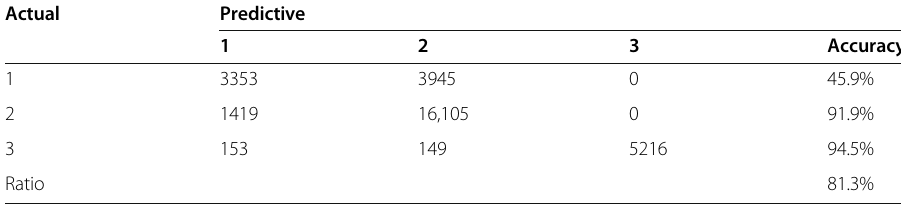
Table 5 Discriminant analysis of multiple logistic total factor regression